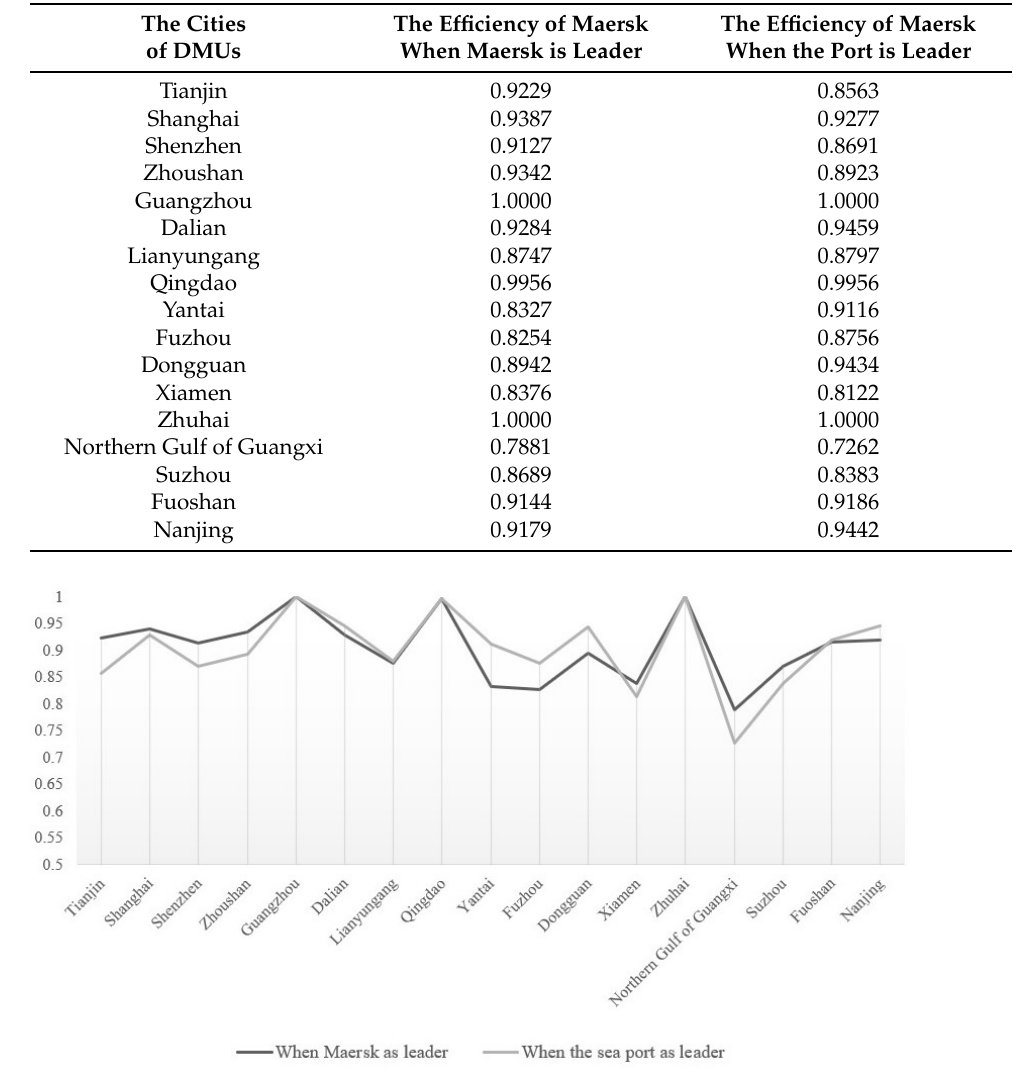
Figure 4. The sustainable efficiency of Maersk under different